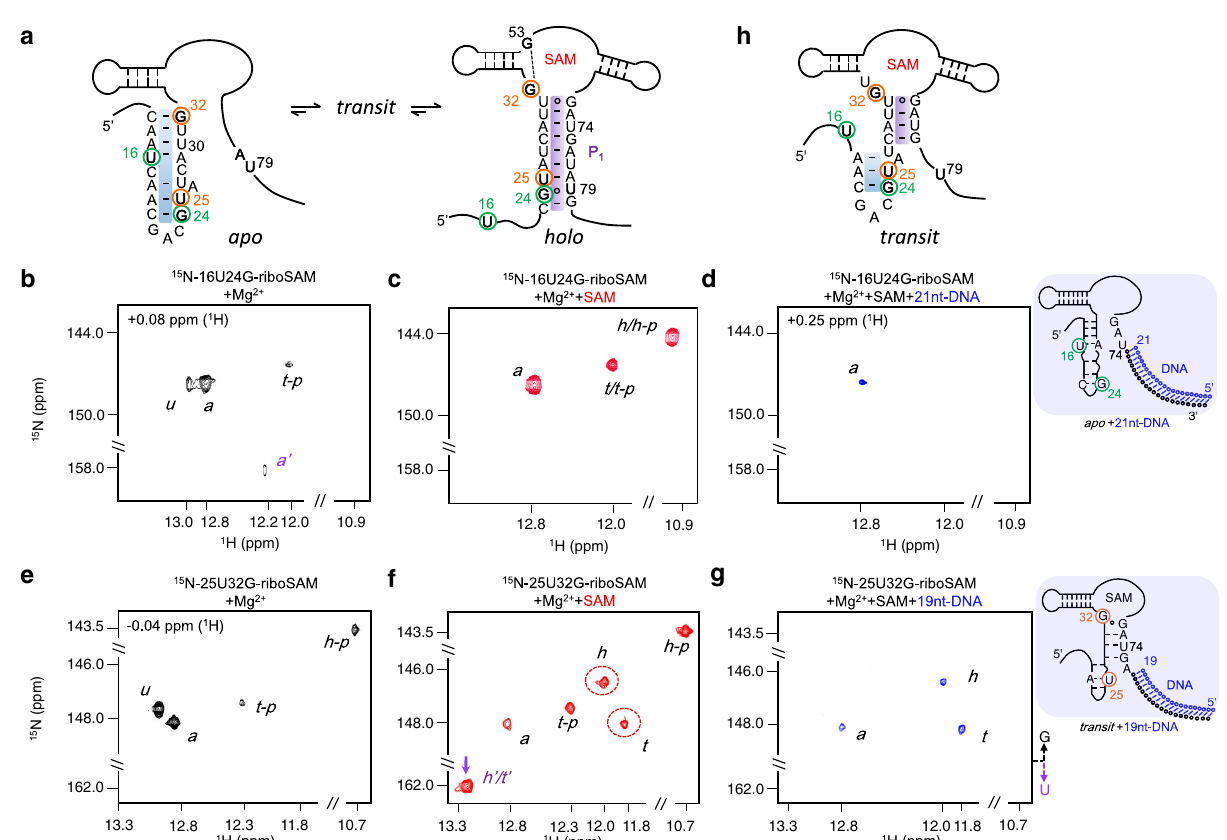
Fig. 6 | Applications of NMR to determine the structural change of riboSAM. a The secondary structures of 15 N-riboSAM. The 15 N-labeled sites, 16U and 24G in 15 N-16U24G-riboSAMare showningreencircles. The 15 N-labeledsites, 25Uand 32G in 15 N-25U32G-riboSAM are shown in orange circles. b – d 1 H 15 N-HSQC spectra were recorded for 15 N-16U24G-riboSAM at 2mM Mg 2+ in the presence of 0mM SAM ( b ), 0.5mM SAM ( c ), 0.5mM SAM and 21 nt-DNA ( d ). The 21 nt-DNA is shown as blue